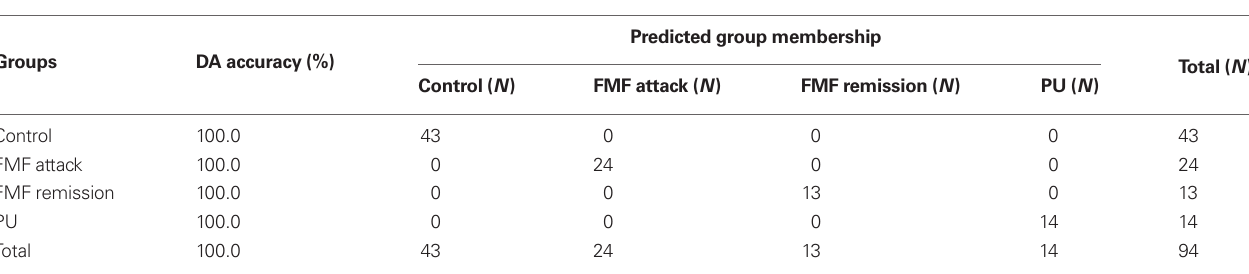
Table 2 | Classification table of correct estimates based on 35 variables set.